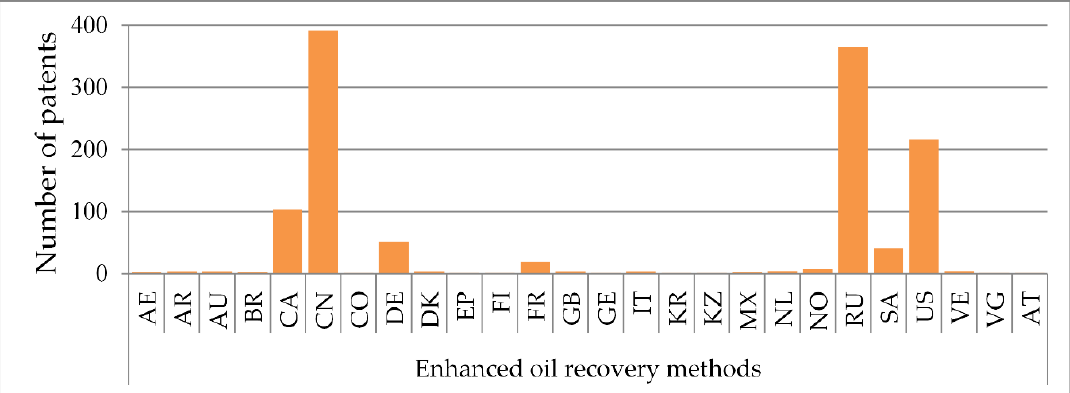
Figure 3. Distribution of the number of patent documents on enhanced oil recovery methods for the period 2010–2020 by country.